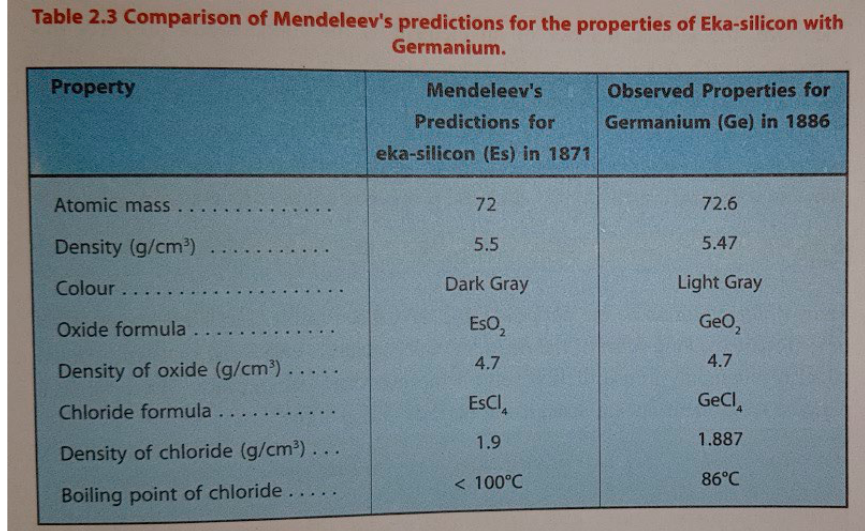
Figure 1. Sharma et al. 29 textbook representation of importance of prediction as evidence to support the periodic